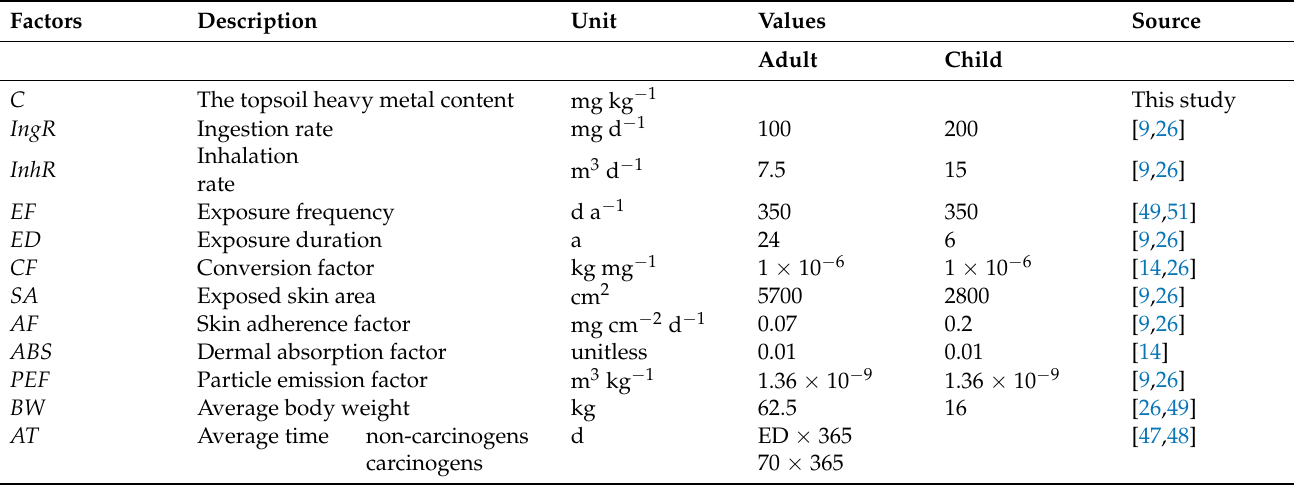
Table 1. Parameters for exposure models.